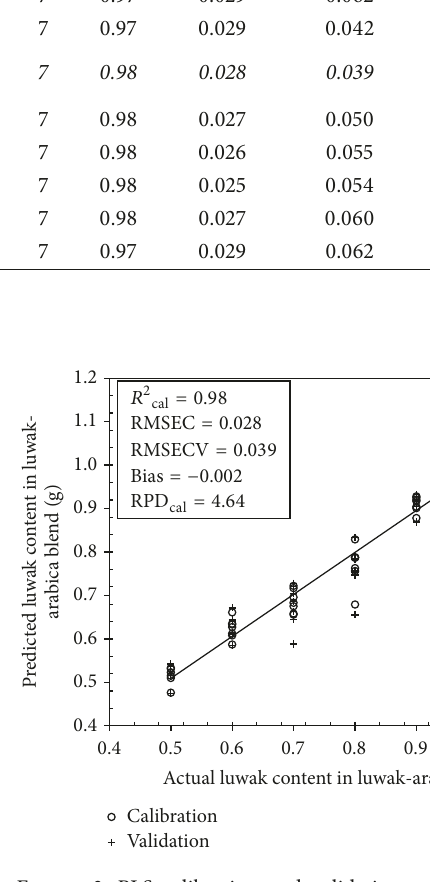
Figure 3: PLS calibration and validation model for luwak con- tent determination using SG smoothing spectra in the range 190–700 nm.